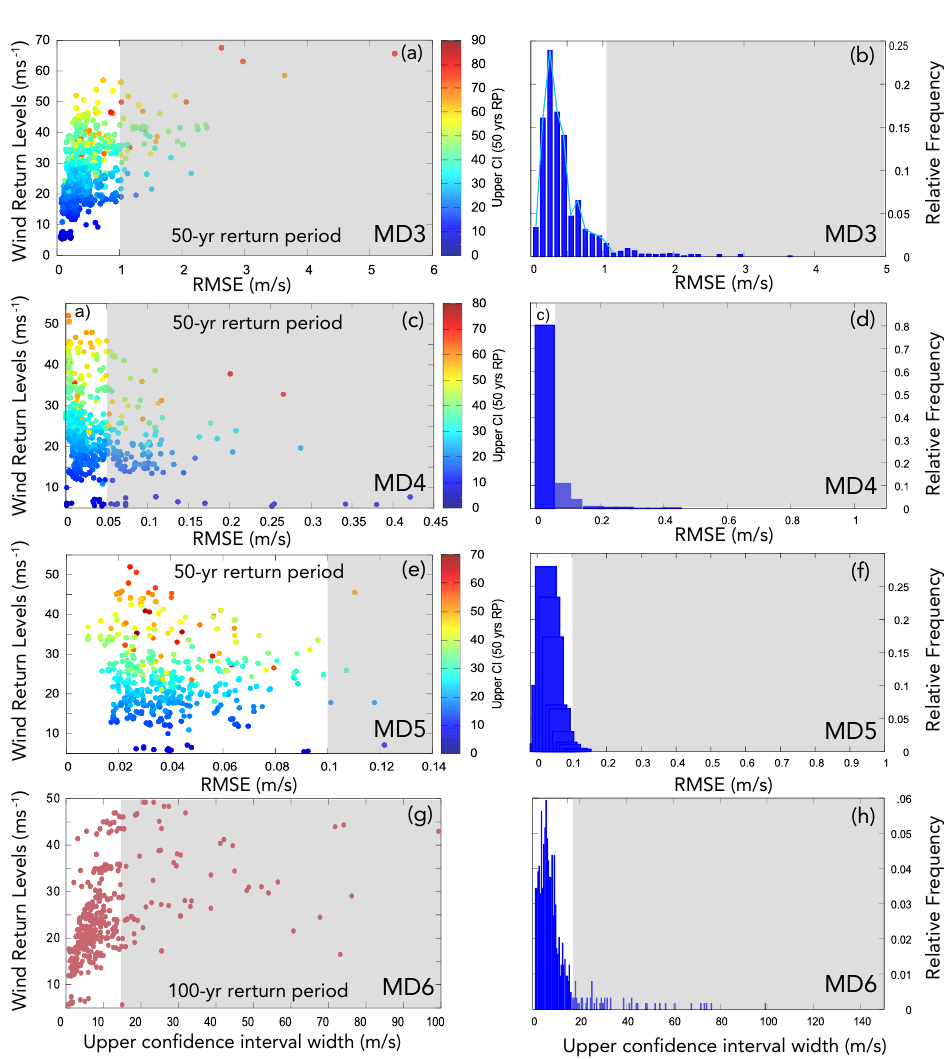
Figure 5. Sequential model diagnostics. Left . 50-year RMSE values calculated at all locations and for all remaining experiments from the previous test as ( a ) the difference between the observed and the theoretical quantiles (q-q plot), ( c ) the difference between empirical and theoretical density functions (h-h plot), ( e ) the difference between empirical and theoretical probabilities (p-p plot), the color indicates the upper 95th confidence limit of the corresponding return value before the filter is applied; ( g ) the wind return levels against the confidence interval width for a return period of 100 years from the evaluation in MD5. Right . ( b , d , f , h ): histograms of relative frequencies (with respect to the number or remaining experiments from each previous test) of RMSE values before the corresponding filter is applied. Grey shadow in all panels stand for the RMSE values of experiments that are filtered out in each